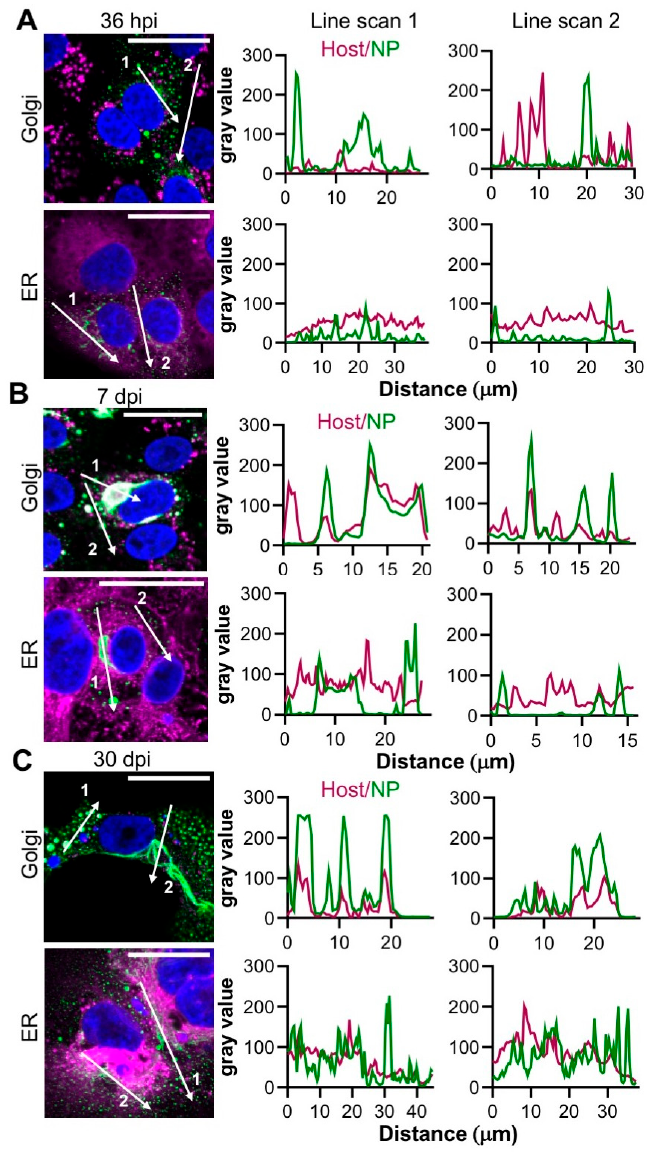
Figure 5. Co-localisation between the TULV NP and either the endoplasmic reticulum (ER) or the Golgi compartments at the early, peak and persistent stages of TULV infection in Vero E6 cells. The spatial distribution of the endoplasmic reticulum and the Golgi network (both magenta) was observed alongside TULV NP (green) in Vero E6 cells infected with TULV at an MOI of 0.1 by confocal microscopy at 40 X magnification at ( A ) 36 h post infection (hpi), ( B ) 7 days post infection (dpi) and ( C ) 30 dpi. The scale bars represent 30 µ m. Fluorescent line scans were taken using Fiji software with the designated number labels corresponding to the adjacent line scan plots. Nuclei were stained with DAPI (blue), TULV NP was detected using NP antisera, with the ER detected using concanavalin-A and the Golgi was detected by specific antisera. Images shown in panels A, B and C show a representative analysis of the 19, 27 and 13 cells,